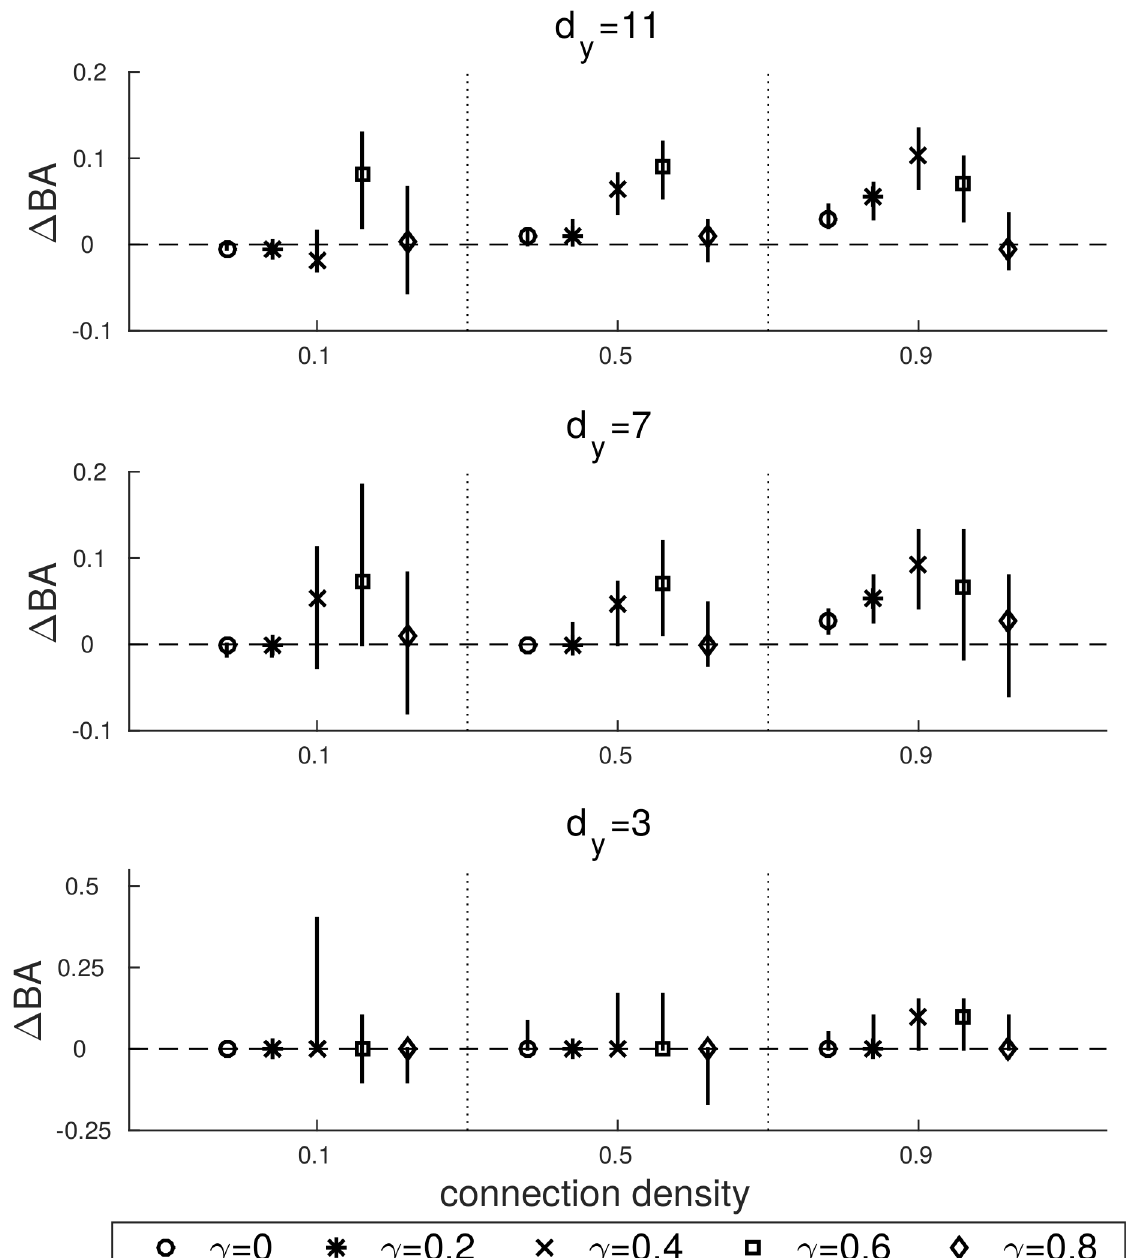
Fig 6. Δ BA computed on the causal configuration matrices estimated by GMEP and